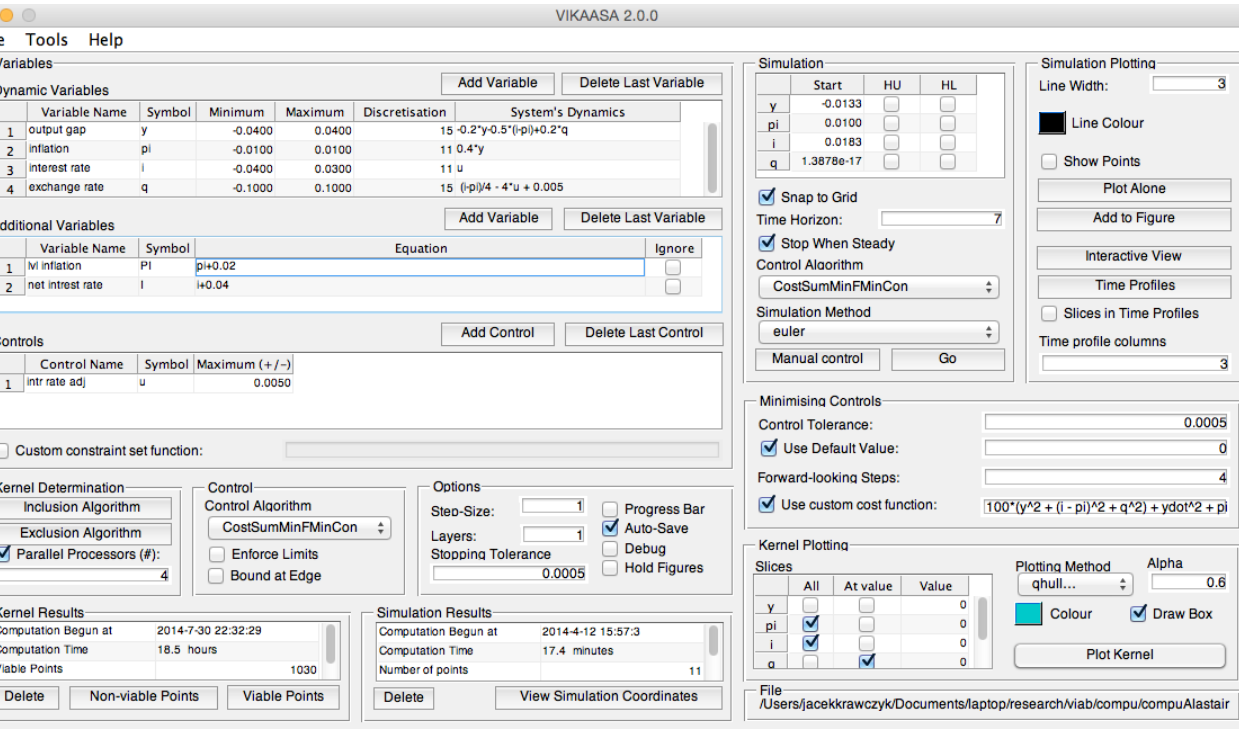
Figure A1. VIKAASA main